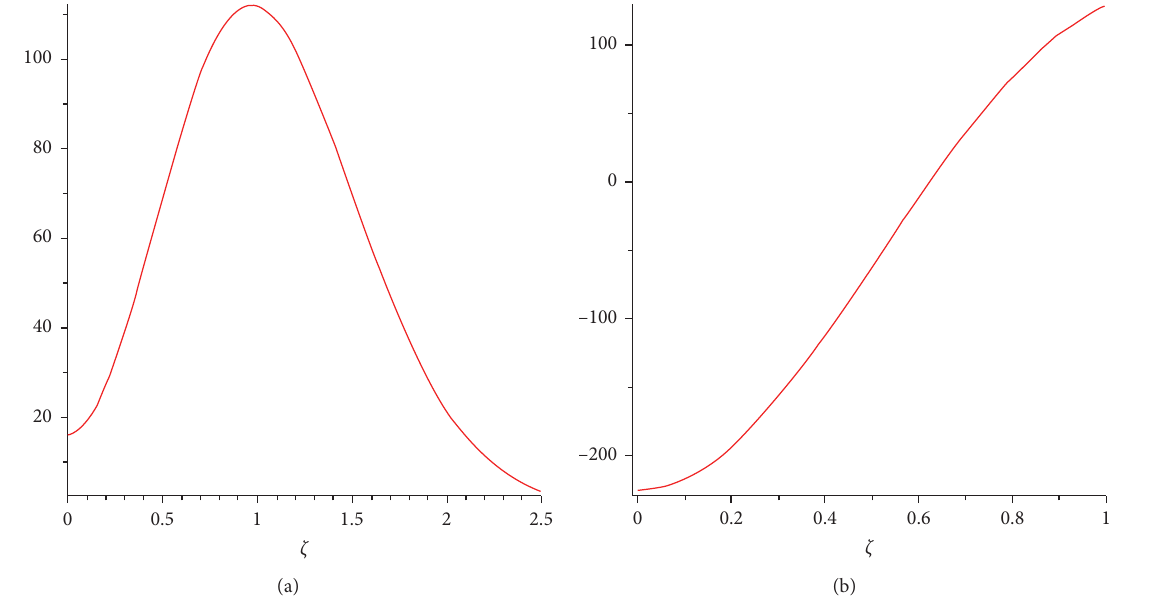
Figure 3: HPTM solutions of μ ( ζ , Ψ ) and ρ ( ζ , Ψ ) at c � 1.